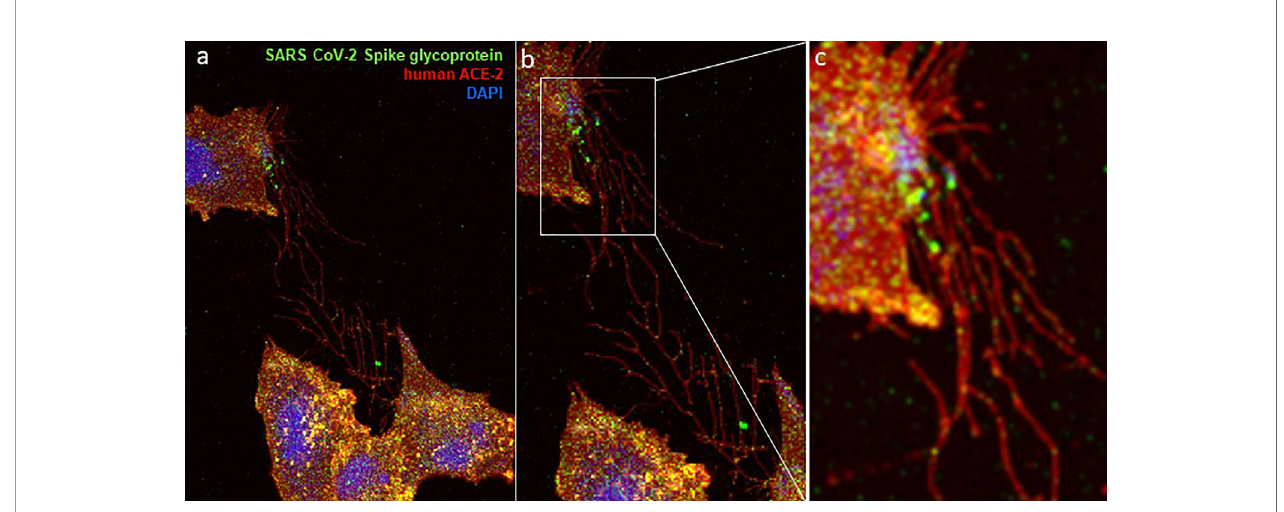
FIGURE 7 | Visual evidence of TNTs network is shown during the co-culture of a target cells (expressing the human ACE-2/heparan sulfate receptor) and the effector cell (expressing the SARS CoV-2 spike glycoprotein). Co-culture of heparan sulfate rich Chinese hamster ovary (CHO-K1) cells expressing GFP-spike glycoprotein with the CHO-K1 cells expressing RFP-tagged ACE-2 cells show the complex network of TNTs between the cells (A – C) . A higher GFP signal for SARS CoV-2 spike glycoprotein at the cellular tip including within the TNT bridges is highlighted in panel b and panel c. Confocal microscopy on the fi xed co-cultured CHO-K1 cells was performed after 48 hours post-mixing using a 60× oil objective (Nikon Eclipse